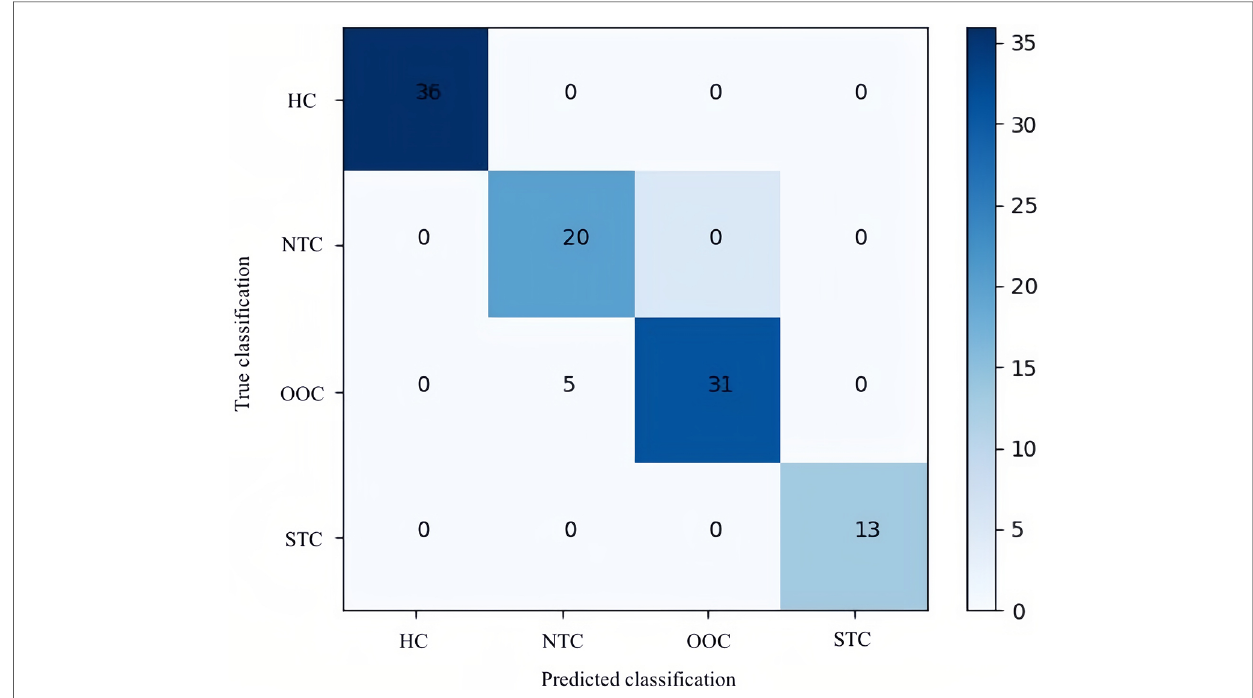
FIGURE 4 Confusion matrix of the optimal LGBM model. This confusion matrix depicts the accuracy of the LGBM model in IFC subtype classi fi cation. The horizontal axis is the predicted label of IFC subtype classi fi cation, and the vertical axis is the true label. According to the matrix, of the 36 healthy controls included in the test data, 36 were predicted correctly; of the 25 children with NTC, 20 were predicted correctly; of the 31 children with OOC all were predicted correctly; and of the 13 children with STC, 13 all were predicted correctly by LGBM. HC, healthy controls; NTC, normal transit constipation; OOC, outlet obstruction constipation; STC, slow transit constipation.